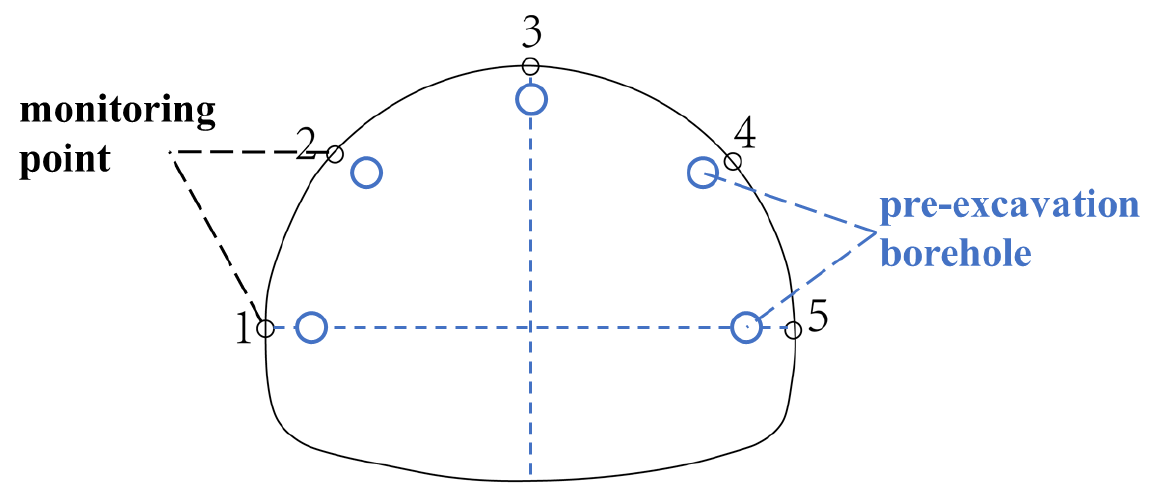
Figure 14. Monitoring point and pre-excavation borehole placement in the tunnel (K143+621). Table 5. Cores collected via pre-excavation boring at each monitoring point and the RBI values.